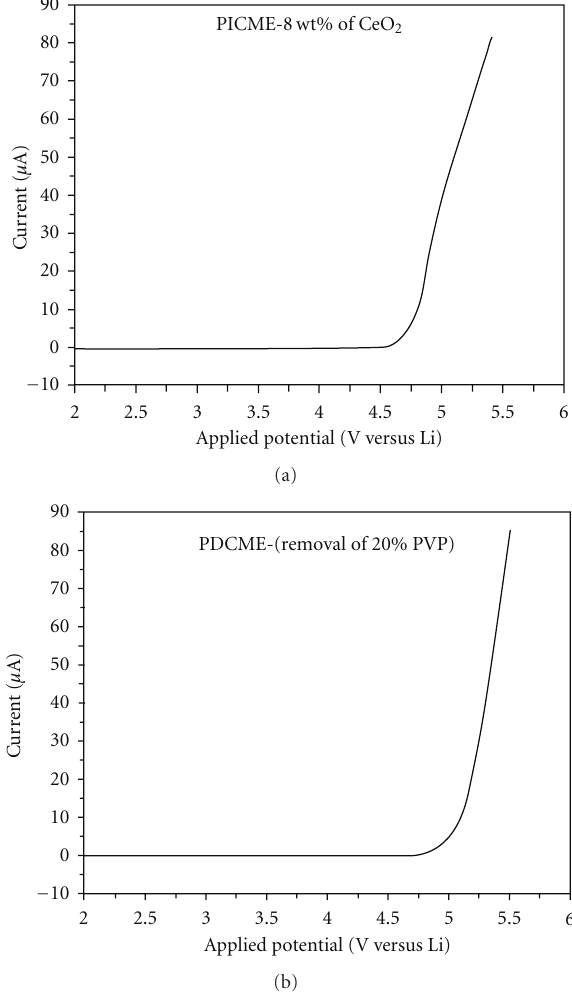
Figure 7: Linear sweep voltammetry of the polymer electrolyte (a) PICME and (b)